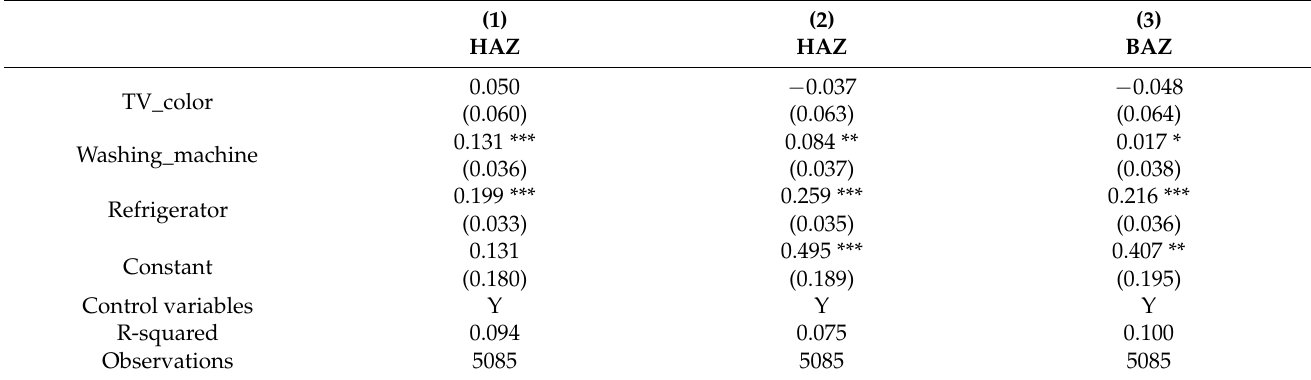
Table 9. Mechanism analysis: impact of household technology on nutrition